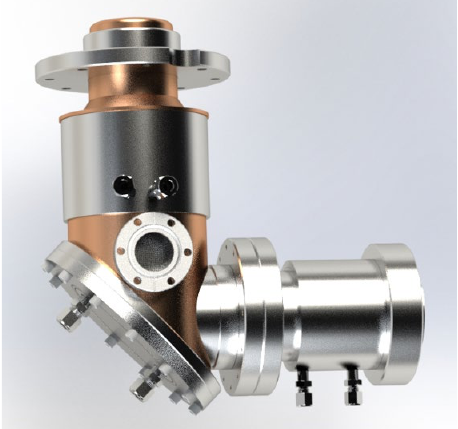
Fig. 8. Solid model of input coupler for 170 GHz operation with 63.5 mm waveguide